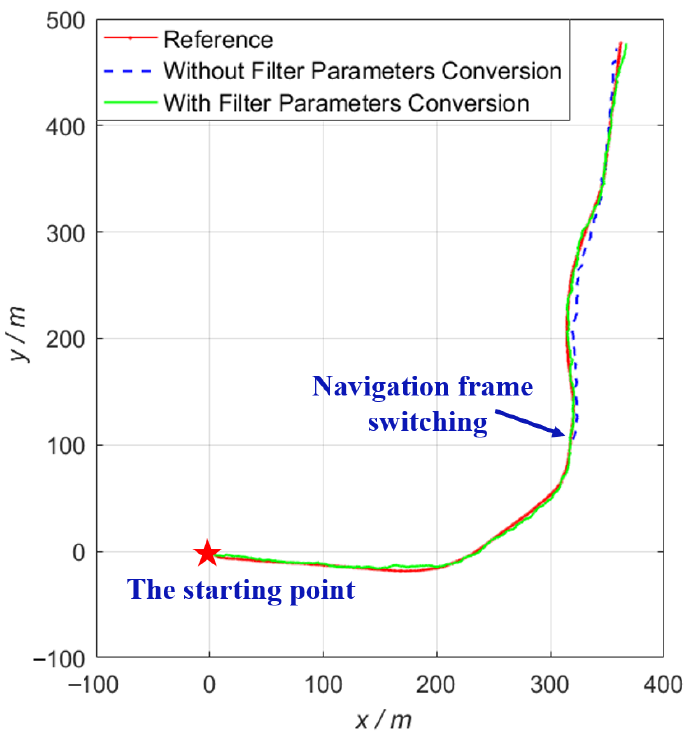
Figure 8. The positions of the two methods with and without filter parameter conversion.